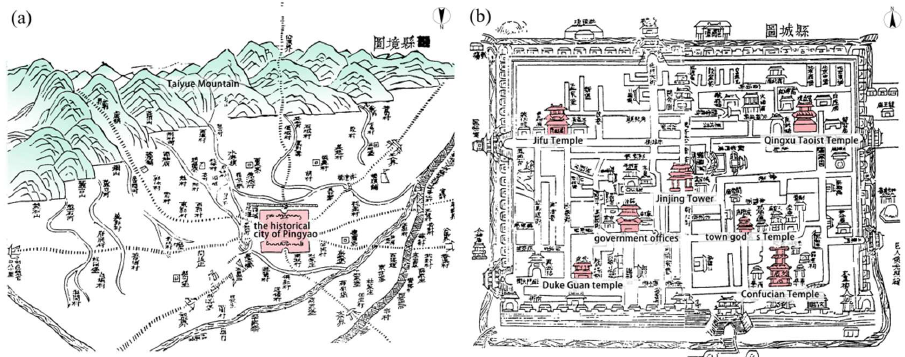
Figure 4. Landscape of the ancient city ( a ) and its urban layout ( b ) of Pingyao in year 1883. (Histor- ical maps retrieved from the local chronicles of Pingyao County in Qing dynasty of Guangxu 9th year